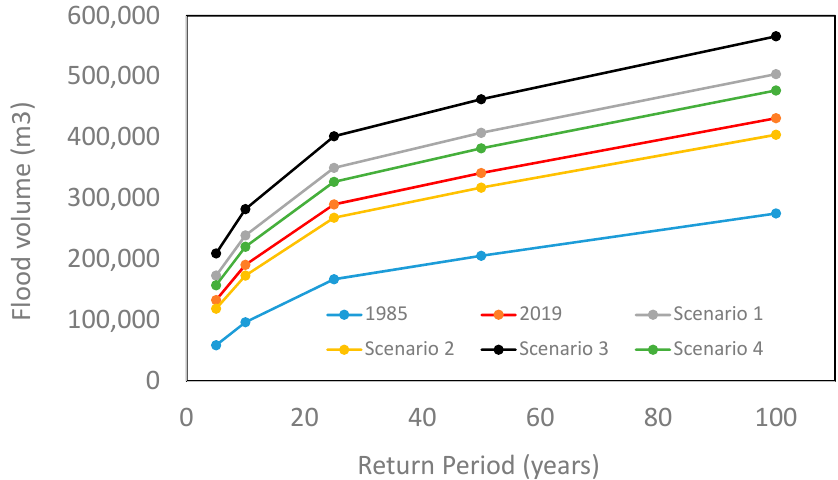
Figure 6. Design flood volume from Esamburmbur for different LULC scenarios.